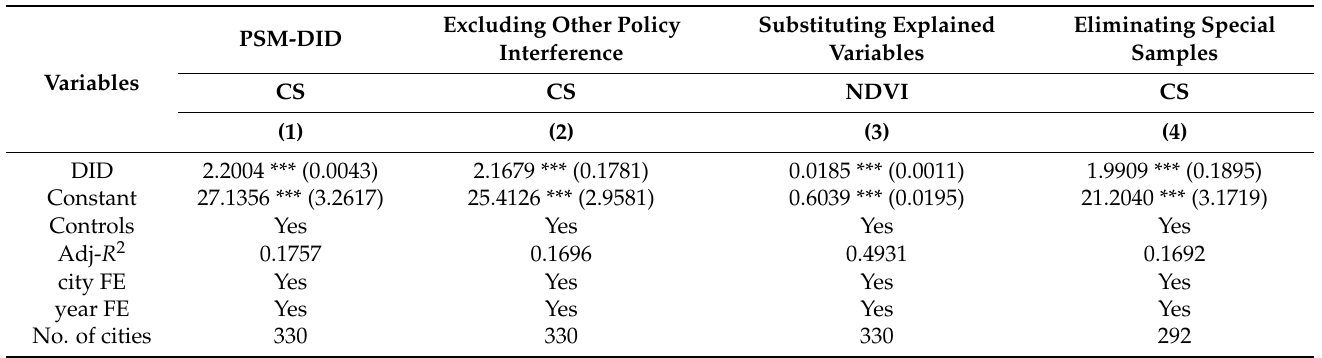
Table 3. Results of robustness